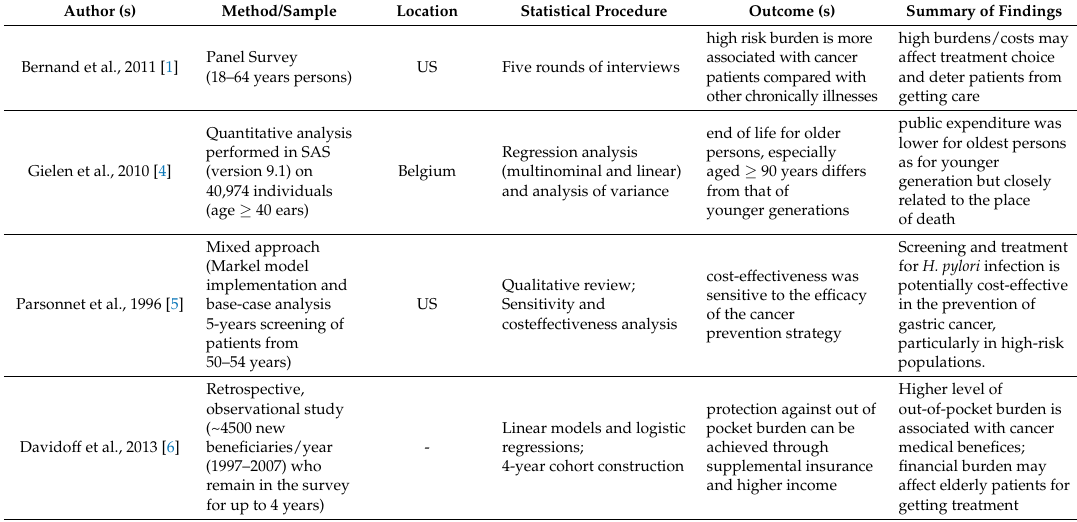
Table 1. Summary of studies concerning cancer